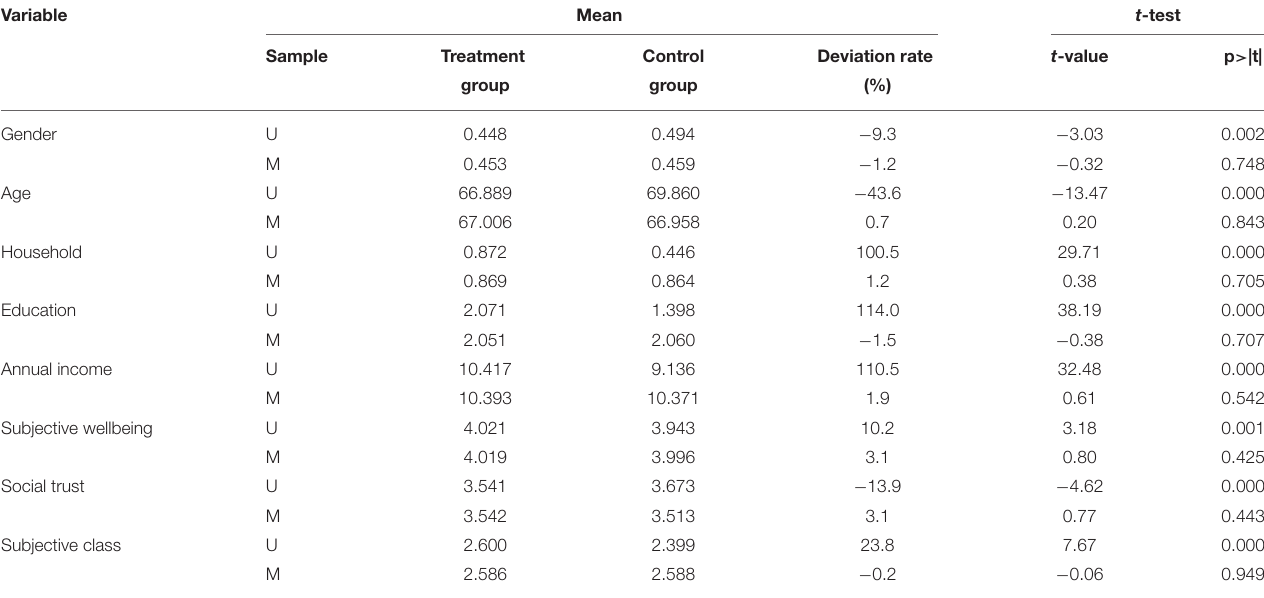
TABLE 4 | Results of balance test. Variable